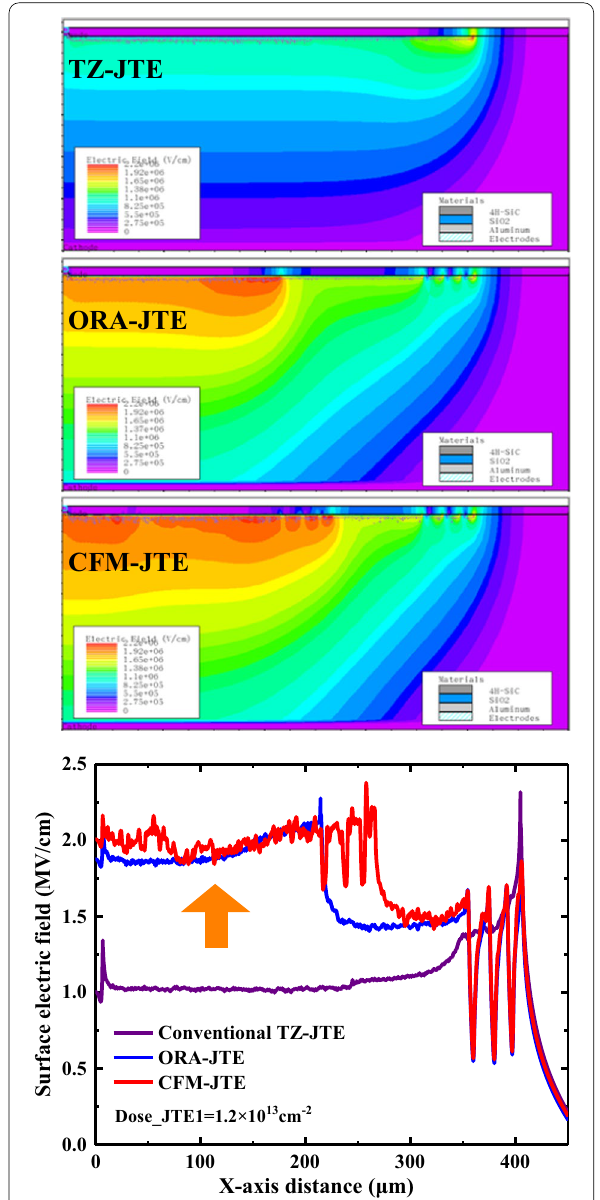
Fig. 3 Reverse surface electric field distribution and intensity in CFM‑JTE, ORA‑JTE and conventional TZ‑JTE